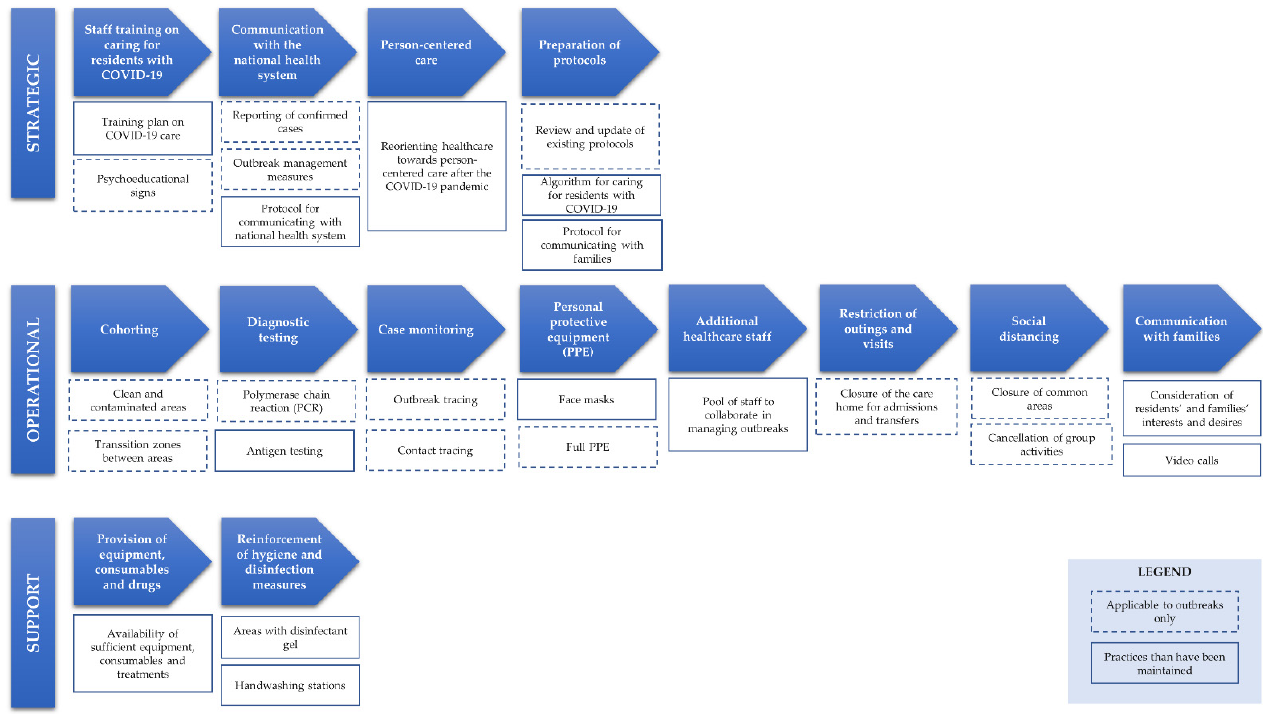
Figure 2. Good practices according to the IDEF model.